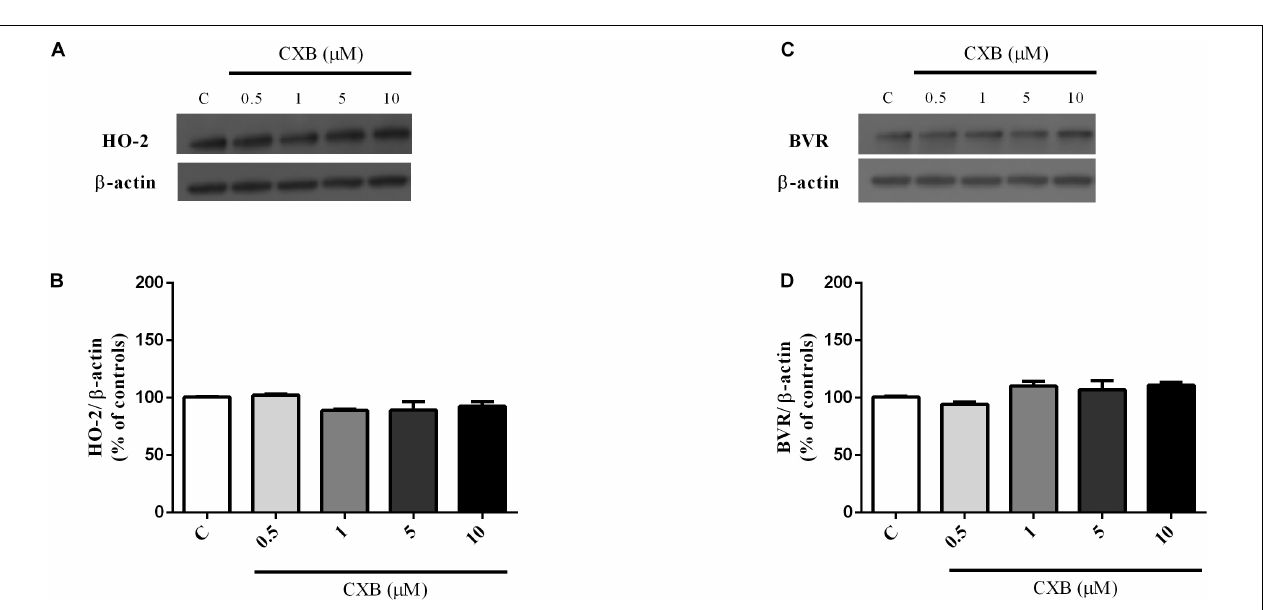
FIGURE 3 | Celecoxib (CXB) effects on basal and A β -induced heme oxygenase-1 (HO-1) expression in SH-SY5Y neurons. SH-SY5Y cells were treated with CXB (0.5–10 µ M) for 1 h and then incubated with cell culture medium for 24 h (A) ; in another set of experiments, SH-SY5Y cells were treated with CXB (0.5–10 µ M) for 1 h and then incubated with 25 nM sA β or 6.25 nM fA β for 24 h ( C,E , respectively). Following incubation, cells were harvested and Western Blot was performed as described in Section “Materials and Methods.” (A,C,E) Show representative gels evaluating HO-1 protein expression. Bar graphs represent the quantification of HO-1 protein levels normalized for β -actin expression. Data are expressed as mean ± SEM of 4/5 replicates per group and analyzed by One-way ANOVA followed by Tukey’s test: * P < 0.05 and ** P < 0.01 vs. C (B) ; ** P < 0.01 vs. C and # P < 0.05 vs. sA β (D) ; *** P < 0.001 vs. C and # P < 0.001 vs. fA β (F) . C, control.